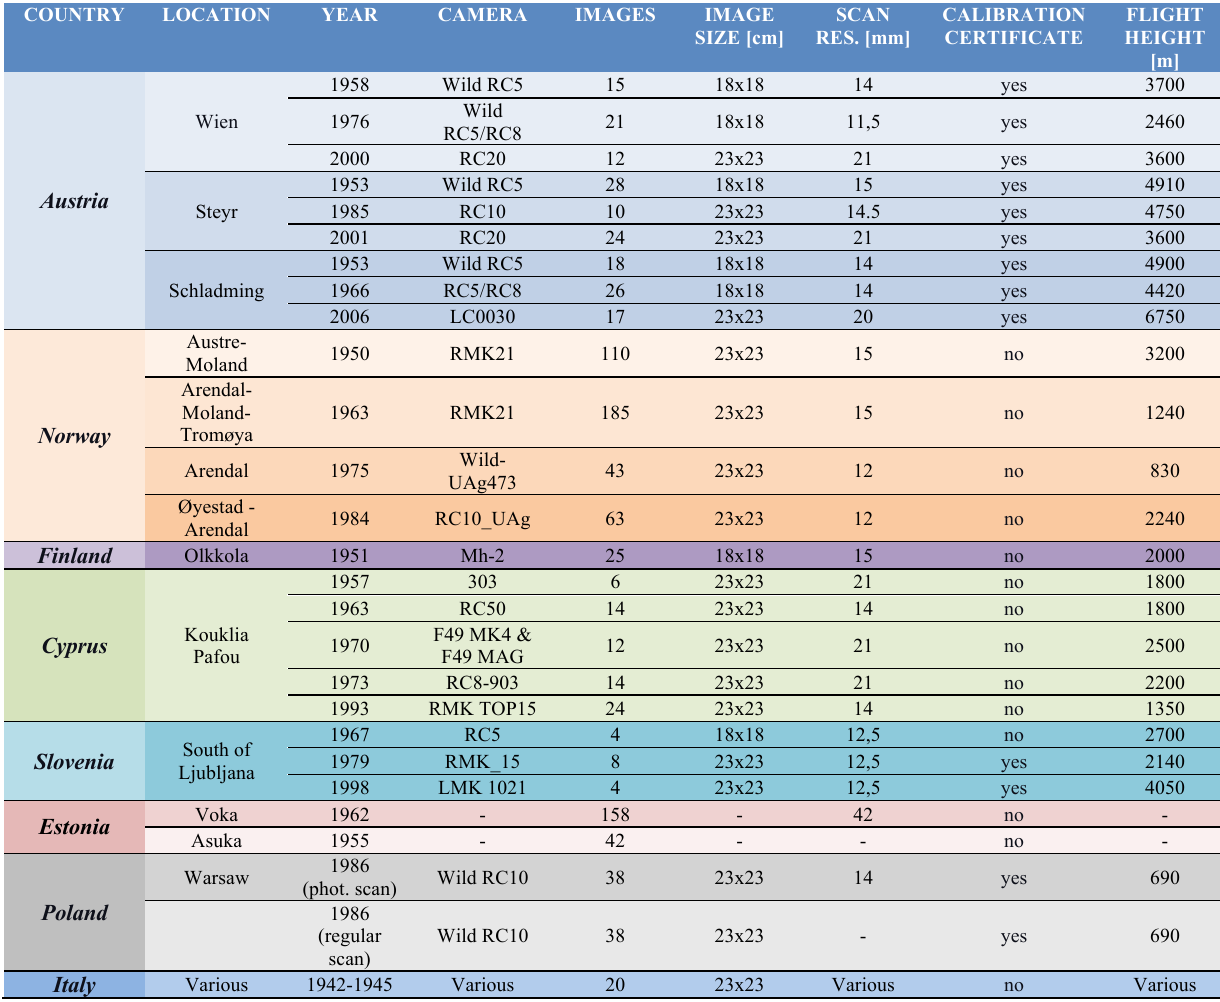
Table 1. Some specifications of the EuroSDR TIME benchmark aerial